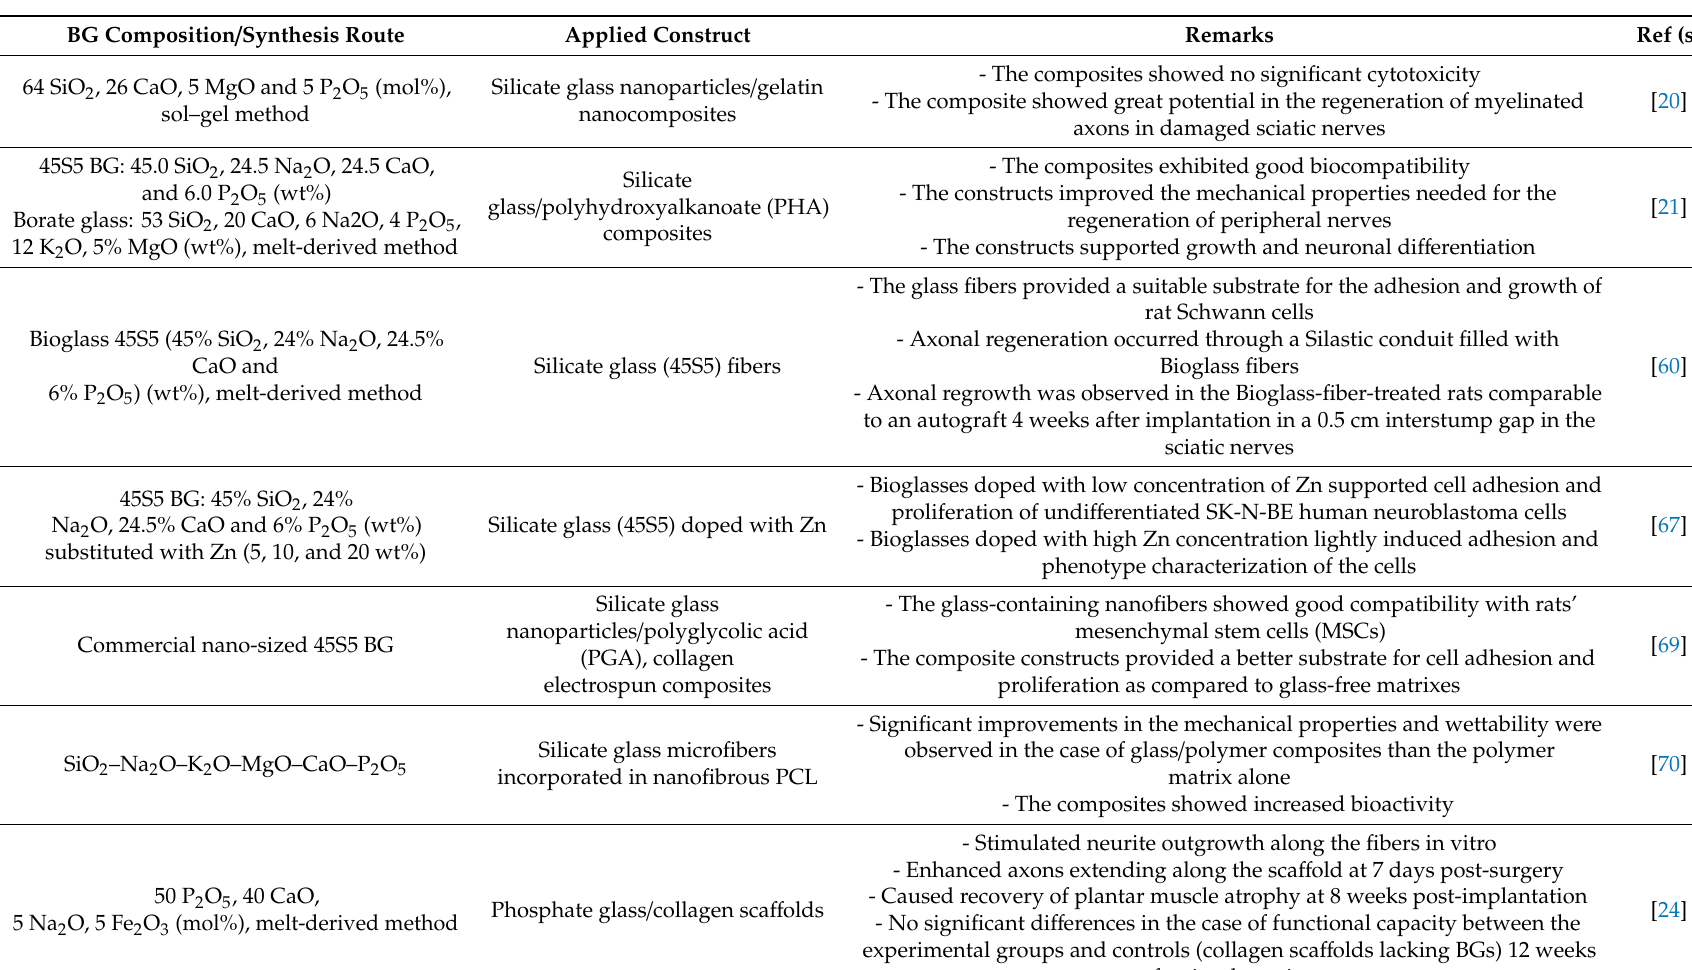
Table 1. A summary of currently available reports showing the suitability of di ff erent types of BGs and glass-based composites in peripheral nerve repair and